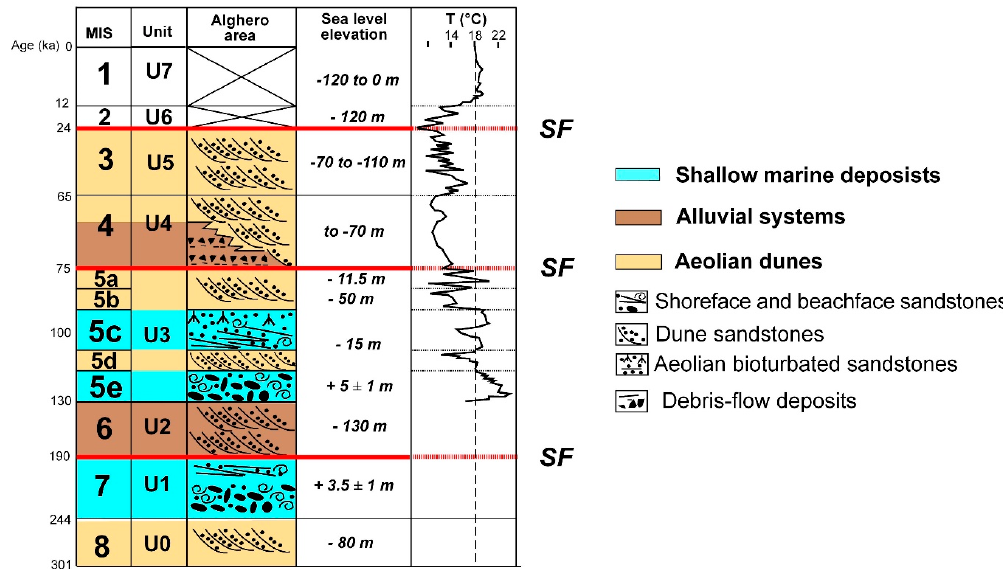
Figure 4. Stratigraphy of the mid-late Quaternary stratigraphic units (U0–U1) revised for this work